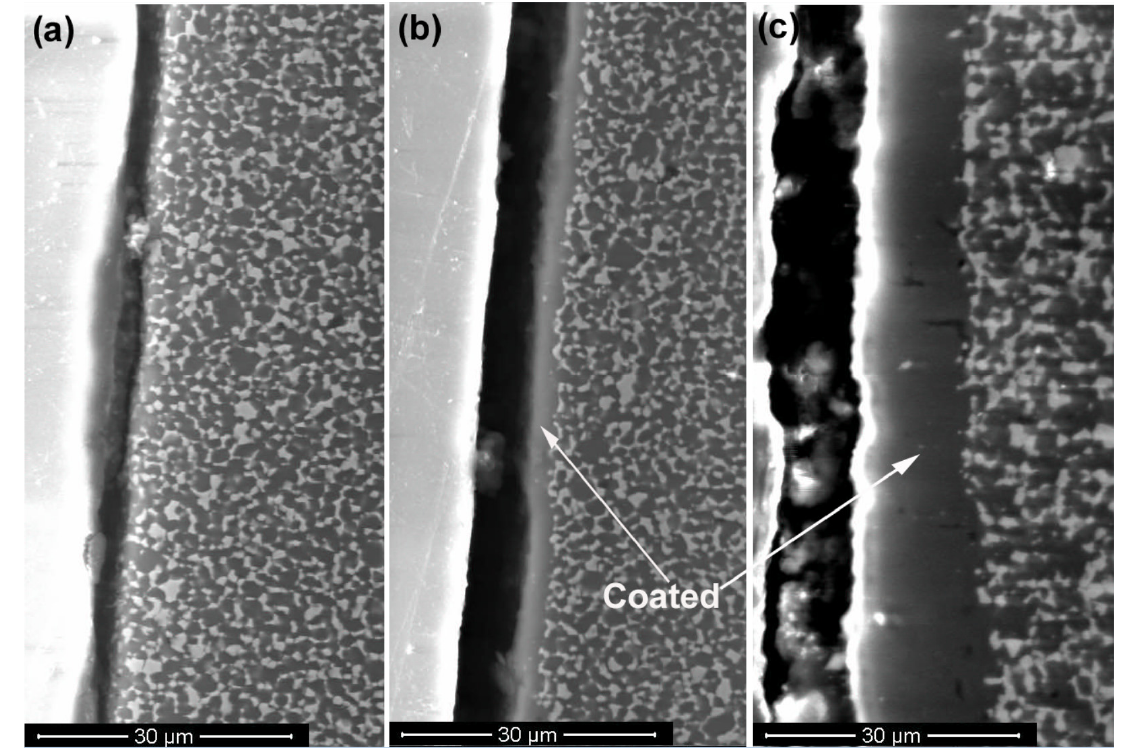
Figure 3. SEM images showing the enlarged view at the interface of ( a ) The uncoated region, ( b ) A ~2.5 μ m Na- β ”-alumina-coated sample, and ( c ) A ~15 μ m Na- β ”-alumina-coated sample. ( b ) A ~2.5 µ m Na- β ”-alumina-coated sample, and ( c ) A ~15 µ m Na- β ”-alumina-coated sample.